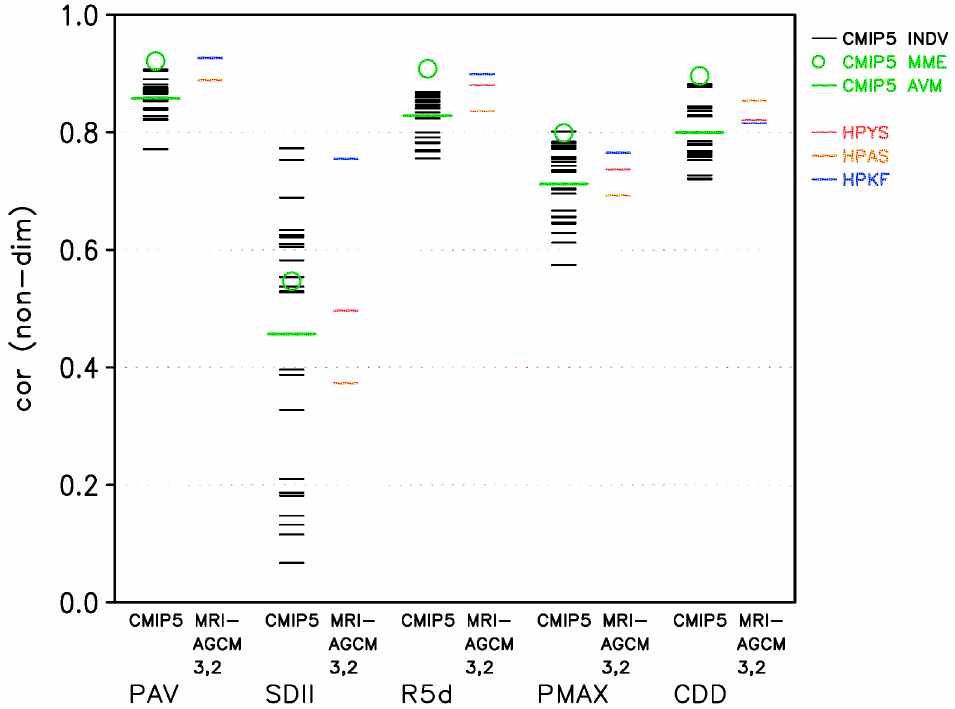
Figure 4. Spatial correlation coefficients of the global distribution of precipitation indices (Table 3) between observations by GPCP 1ddv1.2 and model simulations. Red, orange and blue bars denote the 60-km models with the YS, AS and KF schemes, respectively. Black bars show the CMIP5 individual models. Green circles indicate the MME mean of CMIP5 models. Green bars indicate the AVM of CMIP5 models. CDD, consecutive dry days.